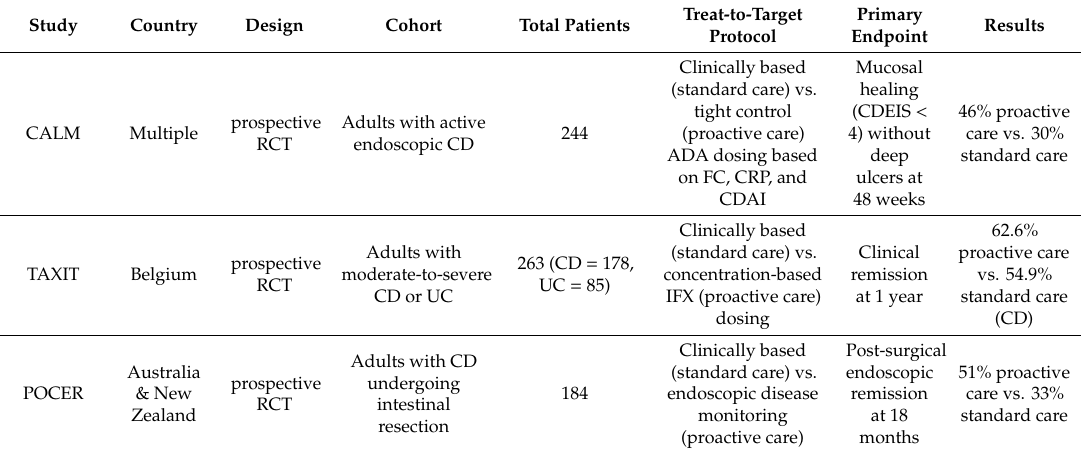
Table 1. Evidence for the proactive management of Crohn’s